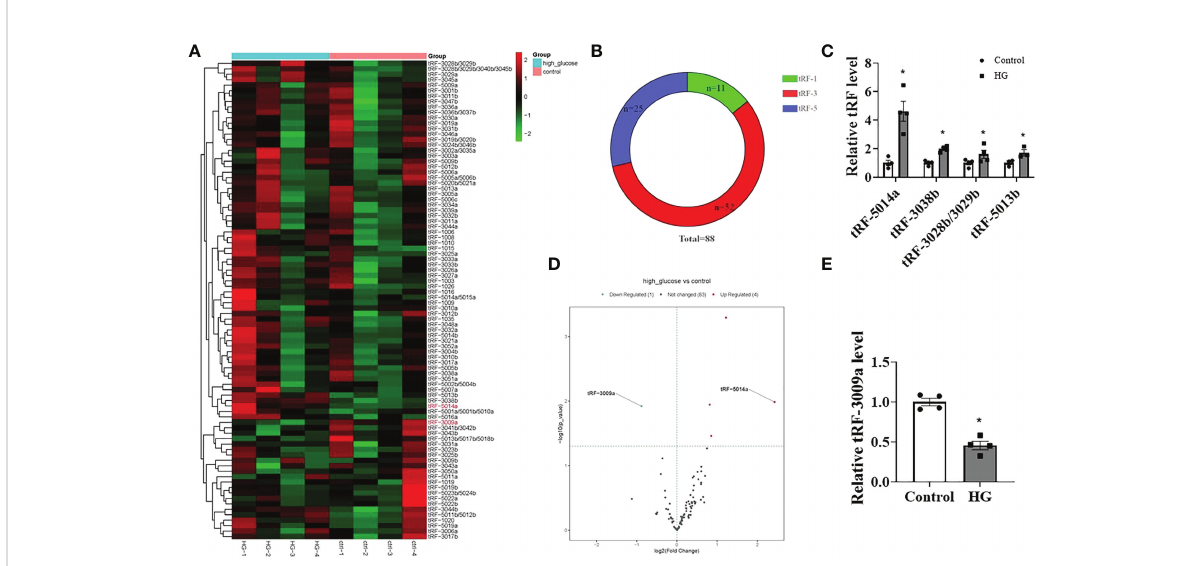
FIGURE 2 Differentially expressed tRFs were detected in HG-treated primary cardiomyocytes. (A, B) The tRF & tiRNA PCR array detected a total of 88 tRFs, which were classi fi ed as tRF-1 (n=11), tRF-3 (n=52) and tRF-5 (n=25). (C – E) Four tRFs were signi fi cantly upregulated and 1 tRF was markedly downregulated in HG-treated cardiomyocytes. n = 4 in each group. * p < 0.05 versus